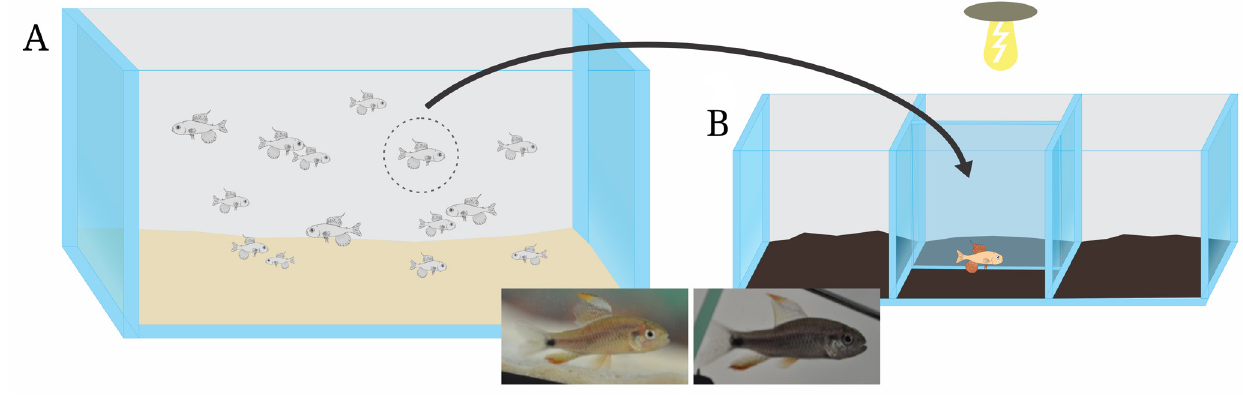
FIGURE 3 | A. Representation of the stock tank, with sandy bottom. B. Representation of experimental tank showing the compartments, leaf litter bottom and light bulb. Inner panes: pictures of fish with bright coloration (in stock tank) and dark coloration (after ten minutes of exposure to leaf litter